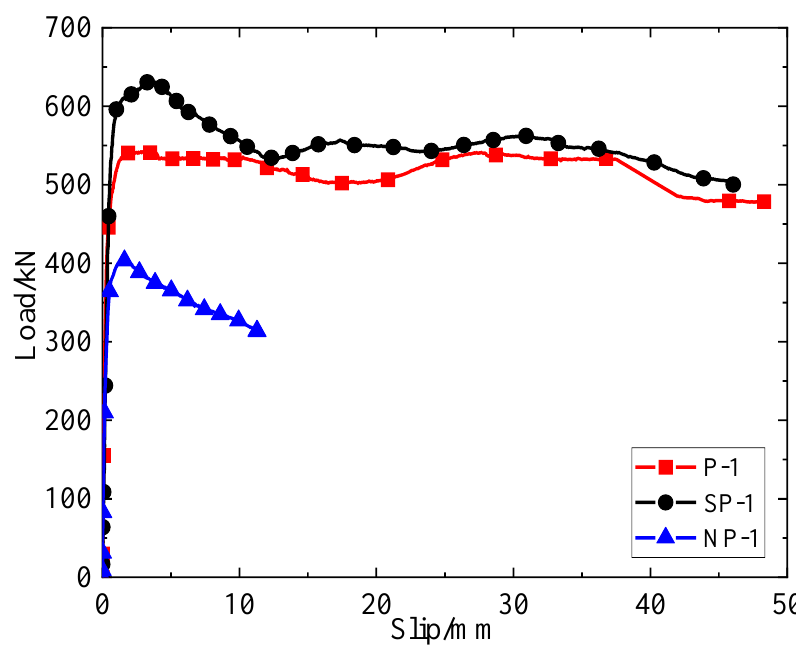
Figure 15. Effect of stirrup form on load–slip curves.